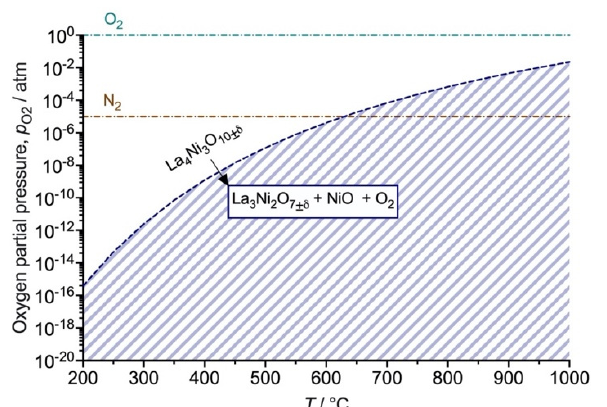
Figure 1. Stability limits calculated for the La 4 Ni 3 O 10 ± δ (LNO) phase as a function of temperature, calculated from data from [21]. The typical p O2 values of O 2 and N 2 atmospheres are indicated as a reference.